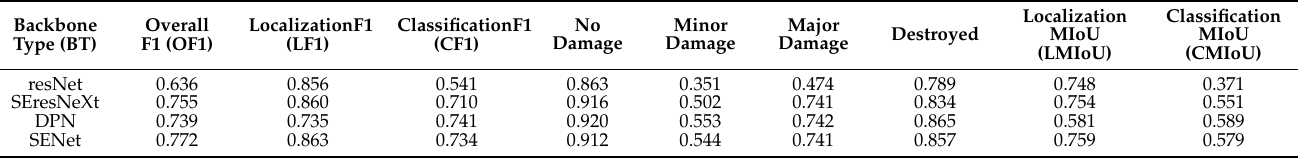
Table 4. Indicators of different models without the attention (w/o A) mechanism. MIoU: Mean Intersection over Union. Backbone Overall Type (BT) F1